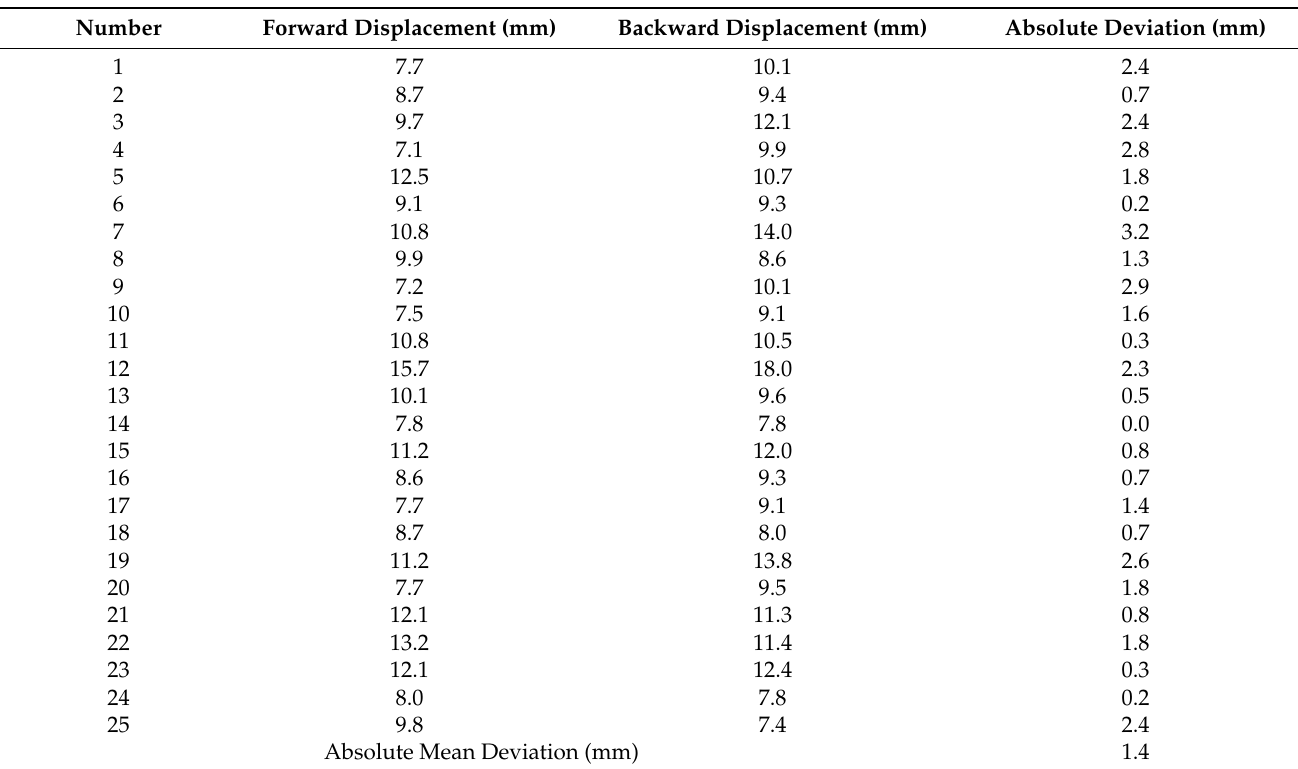
Table 1. Circumferential displacement round-trip precision